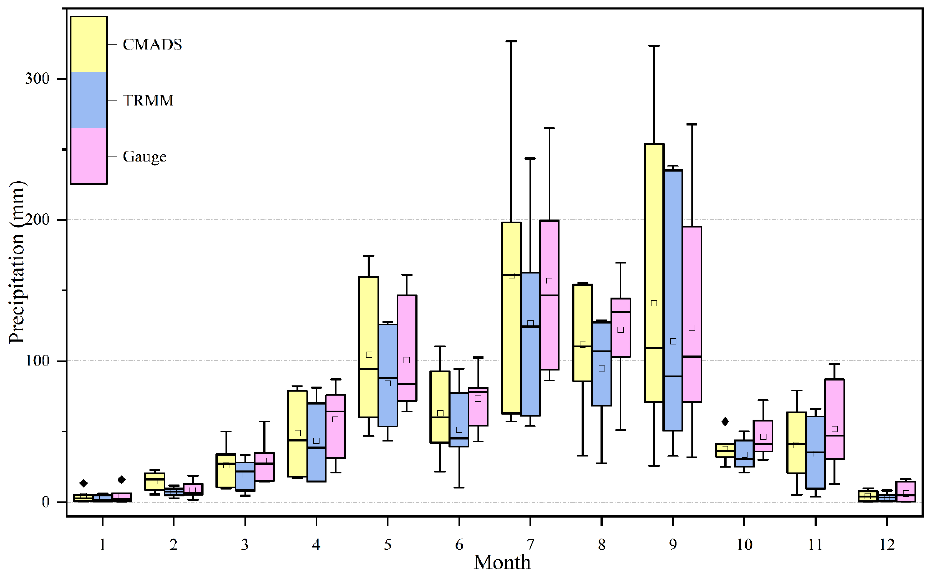
Figure 3. The box diagrams of three precipitation records at a monthly scale in the DRB.